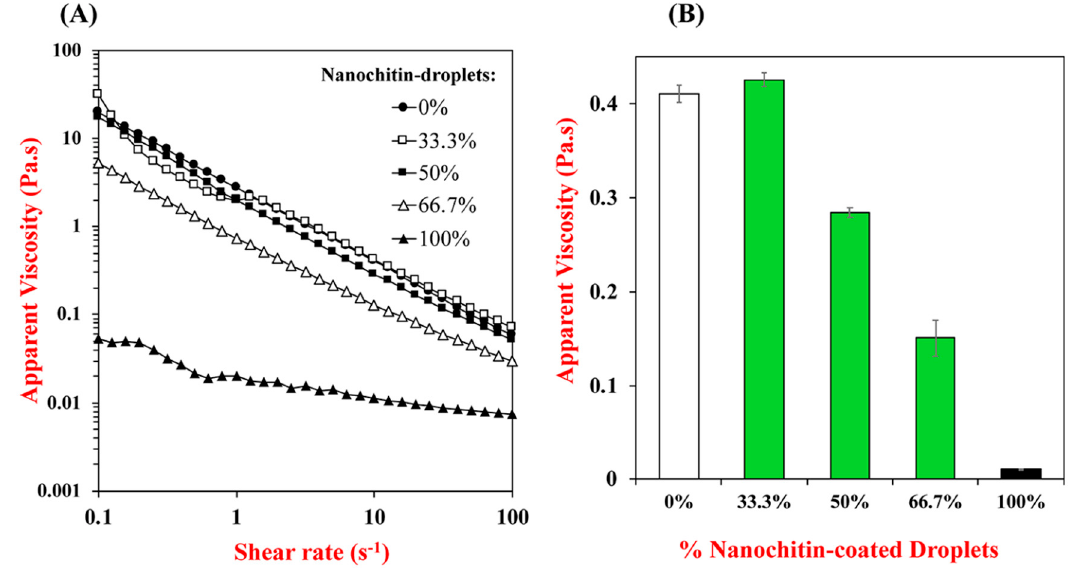
Figure 20. Impact of mixing ratio on the viscosity of mixed nanocellulose and nanochitin-emulsions: ( A ) apparent viscosity versus shear rate; ( B ) apparent viscosity versus percentage of cationic nanochitin-coated droplets present (shear rate = 10 s − 1 ) [92].